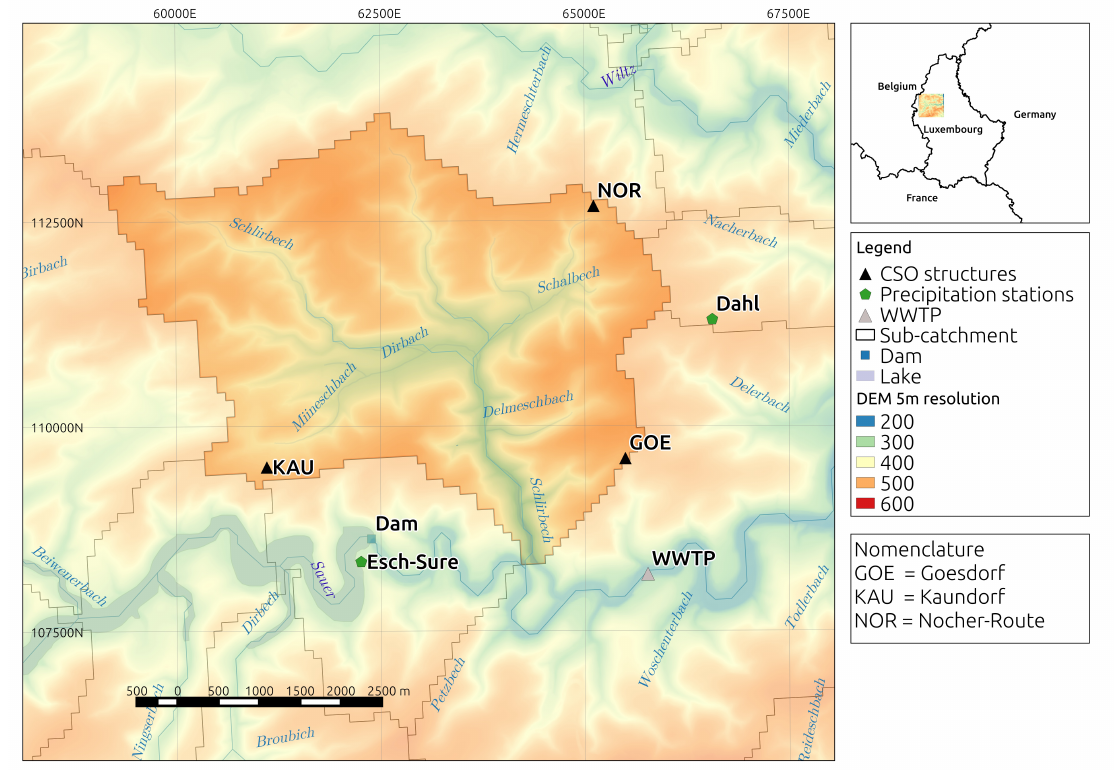
Figure 3. The Haute-Sûre sub-catchment. Combined sewer overflow (CSO) structures are located in Goesdorf (GOE), Kaundorf (KAU), and Nocher-Route